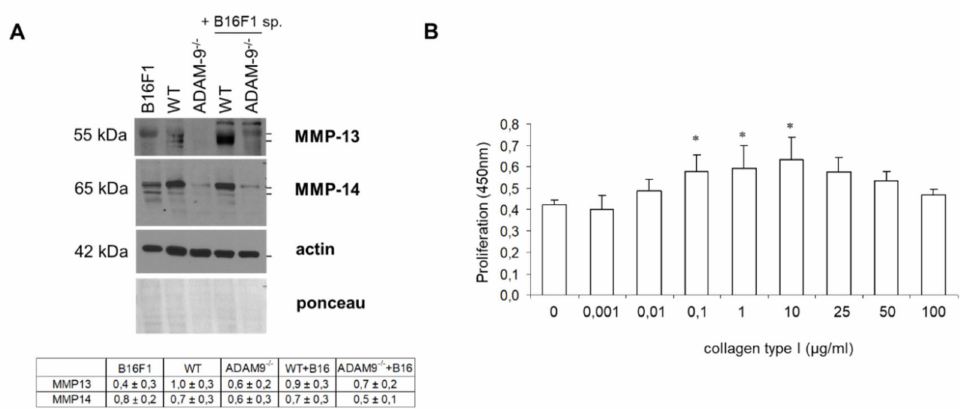
Figure 4. Deletion of ADAM9 leads to reduced expression of collagenolytic enzymes and thereby enhanced tumor cell proliferation. ( A ) MMP-13 and MMP-14 were analyzed by immunoblot in fibroblast supernatants (normalized to amounts of protein lysates) and lysates, respectively. Both ponceau staining of the membrane and actin immunoblot were used as the loading controls. Underneath, the quantification of MMP13 and 14 is shown ( n = 5–9 independent fibroblasts isolation each genotype). ( B ) The proliferation of B16F1 melanoma cells was assessed in the presence of increasing concentrations of purified collagen type I by BrdU incorporation. The graph represents the mean ± SD. p values were calculated for cell proliferation in the presence of collagen type I compared to serum-free untreated control. * p <